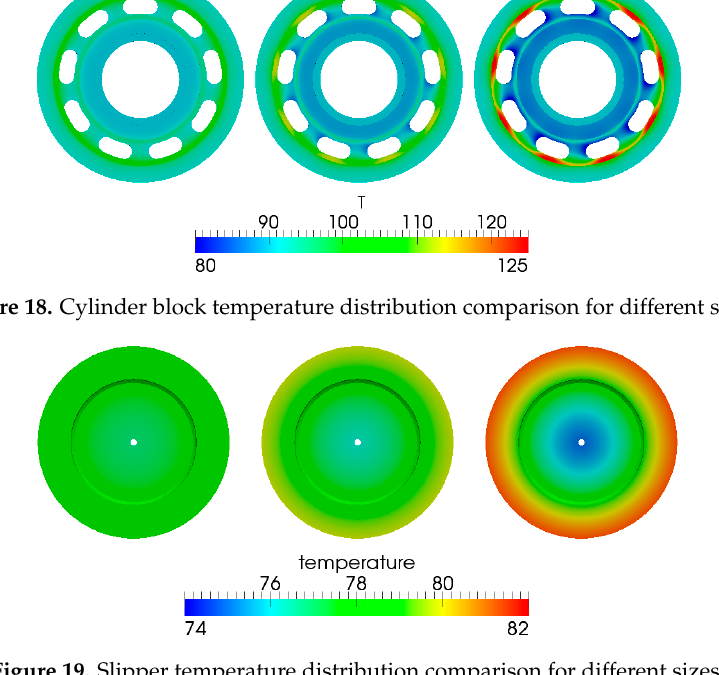
Figure 19. Slipper temperature distribution comparison for different sizes.